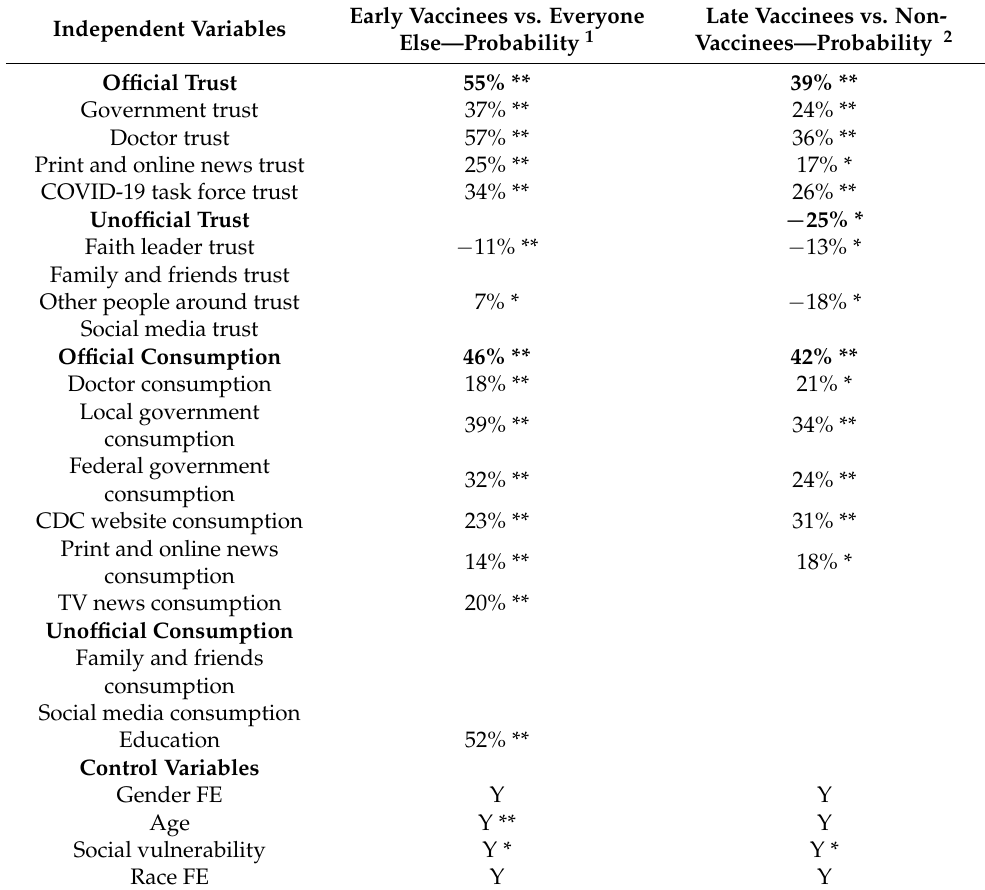
Table A1. Percentage changes as marginal effects of the probit correlation between the probability of being an early/late vaccinee and the education, trust, and consumption variables, which are parallel with Figure 1. For this analysis, the impact of each variable is shown independently of the others. Late Vaccinees vs. Non- Early Vaccinees vs. Everyone Independent Variables Vaccinees—Probability 2 Else—Probability 1 Official Trust 55% ** 39% ** Government trust 37% ** 24% ** Doctor trust 57% ** Print and online news